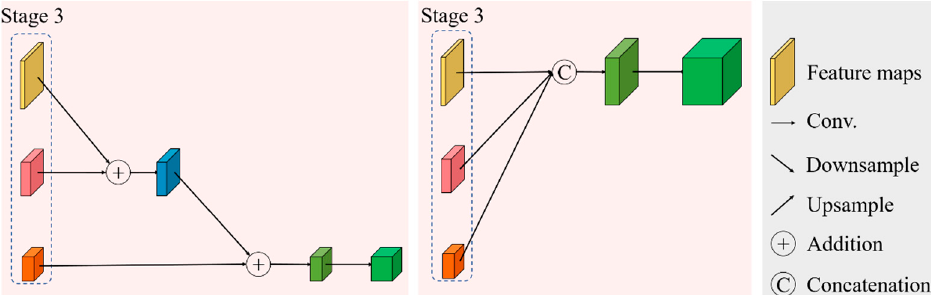
Figure 6. Different types of output heads. Left : down-sampling & addition. Right : up-sampling & concatenation.